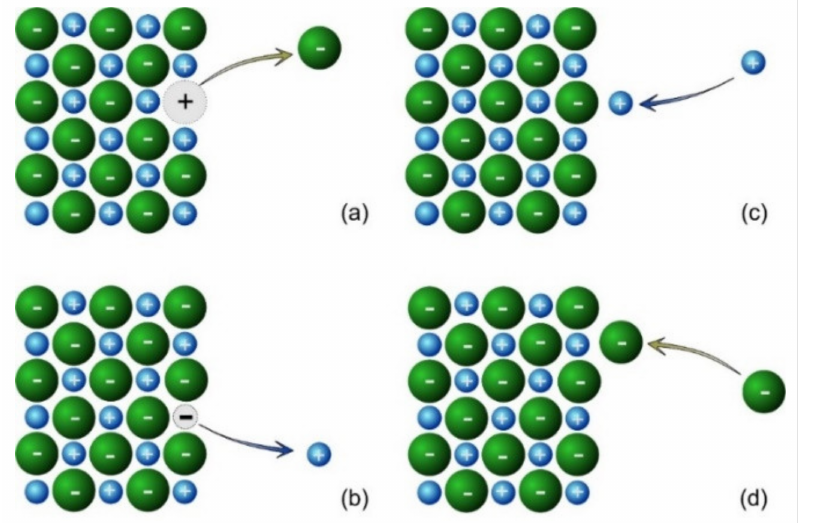
Figure 2. The physical foundation of the surface-vacancy model: ( i ) dissolution occurs by the separate removal of ( a ) anions and ( b ) cations from the surface leaving a charge of the opposite sign on the surface, and the deposition of ( c ) cations and ( d ) anions onto the surface adding a charge of the same sign onto the